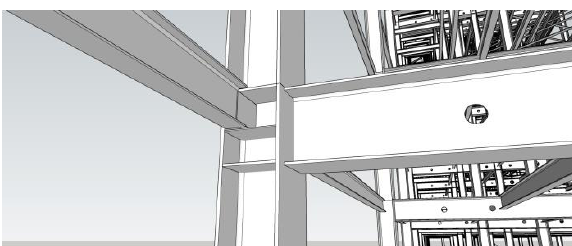
Figure 6: a steel node of the ENI Office Building in Rome.